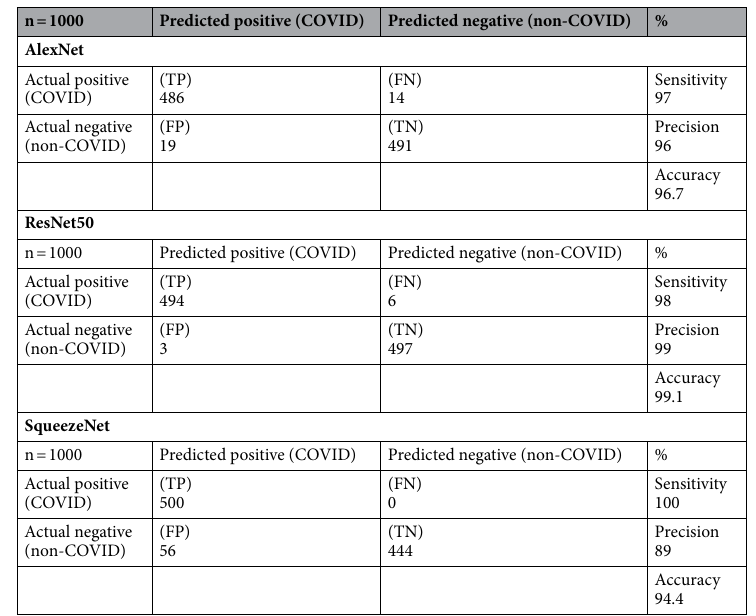
Table 3. Confusion matrix for AlexNet, ResNet50 and SqueezeNet. TP Number of COVID images classified correctly, FP Number of non-COVID images incorrectly classified as COVID, TN Number of correctly classified non-COVID images and FN Number of COVID images incorrectly classified as non-COVID.